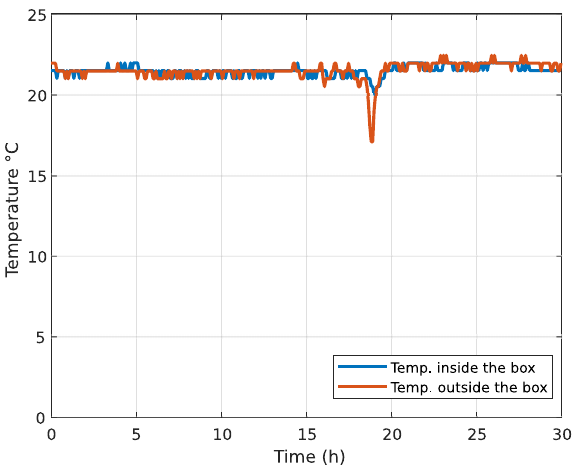
Figure 5. Temperature stability test: The temperature inside the isolated box and temperature outside the isolated box were measured every 5 min for 30